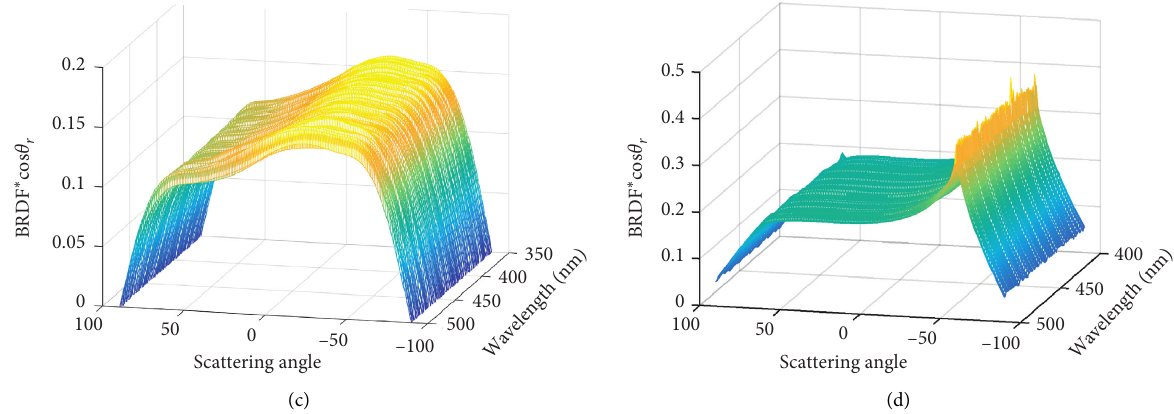
Figure 11: Fitted 3D graph of sample 3. (a) Fitted 3D graph of the 0 ° incident angle; (b) fitted 3D graph of the 30 ° incident angle; (c) fitted 3D graph of the 45 ° incident angle; (d) fitted 3D graph of the 60 ° incident